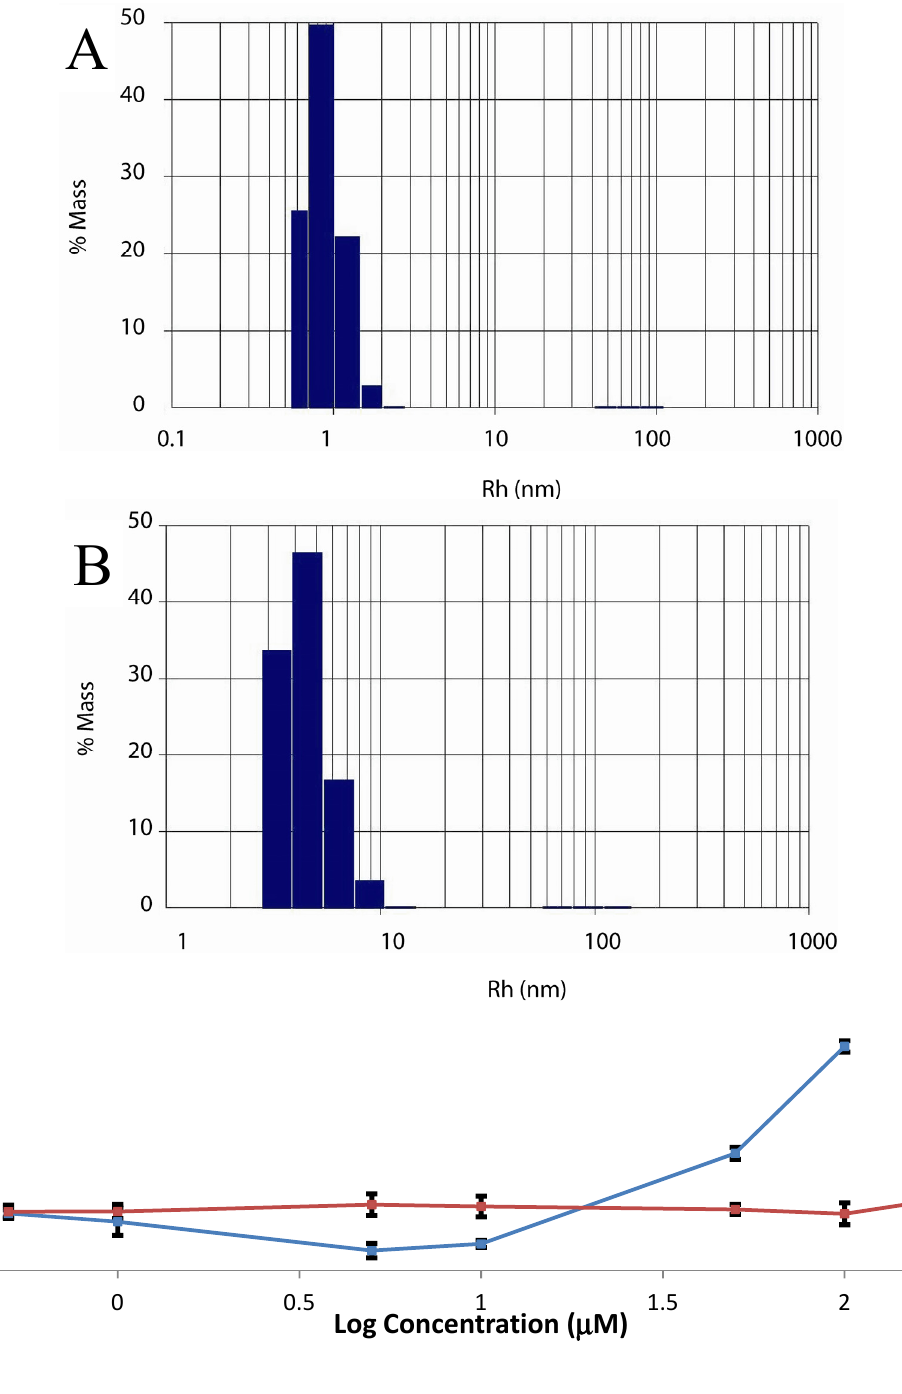
Figure 2. ( A ) Dynamic light scattering of 1mM HVR peptide in PBS at room temperature. ( B ) Dynamic light scattering of 250 μ M FM-HVR peptide in PBS at room temperature. ( C ) The plot of fluorescence intensity ratio (I /I ) from pyrene excitation spectrum as a 334 337 function of concentration of modified and non-modified HVR peptides. The FM-HVR peptide, shown in blue, aggregates beyond 10 μ M. The HVR peptide, shown in red, does not